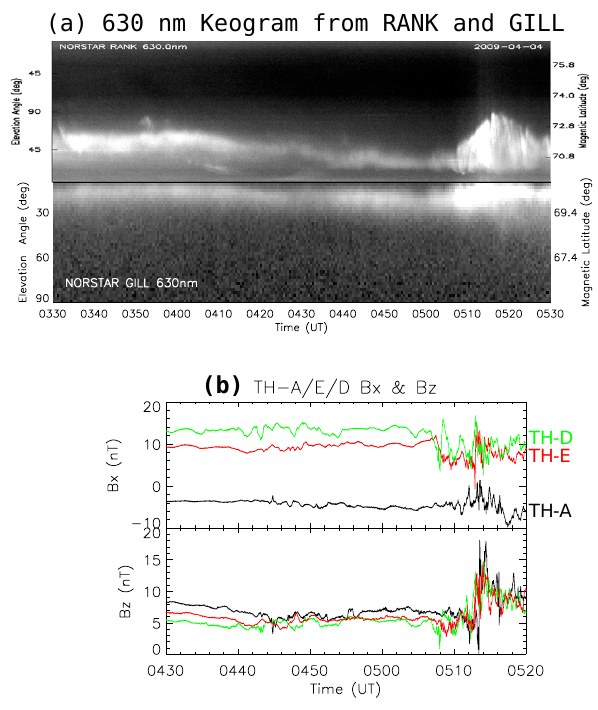
Fig. 10. (a) 630nm auroral keograms from RANK MSI and from GILL MSP. Note that the arcs shown on two keograms are actually the same arc. We label the estimated MLATs as rightside tick by assuming a constant 230km emission height, with the caveat that such estimation is subject to large uncertainty for low-elevation- angle measurement. (b) The in situ B x and B z components on TH- A (black), TH-E (red), and TH-D (green); an inward propagation sequence of substorm disturbance is